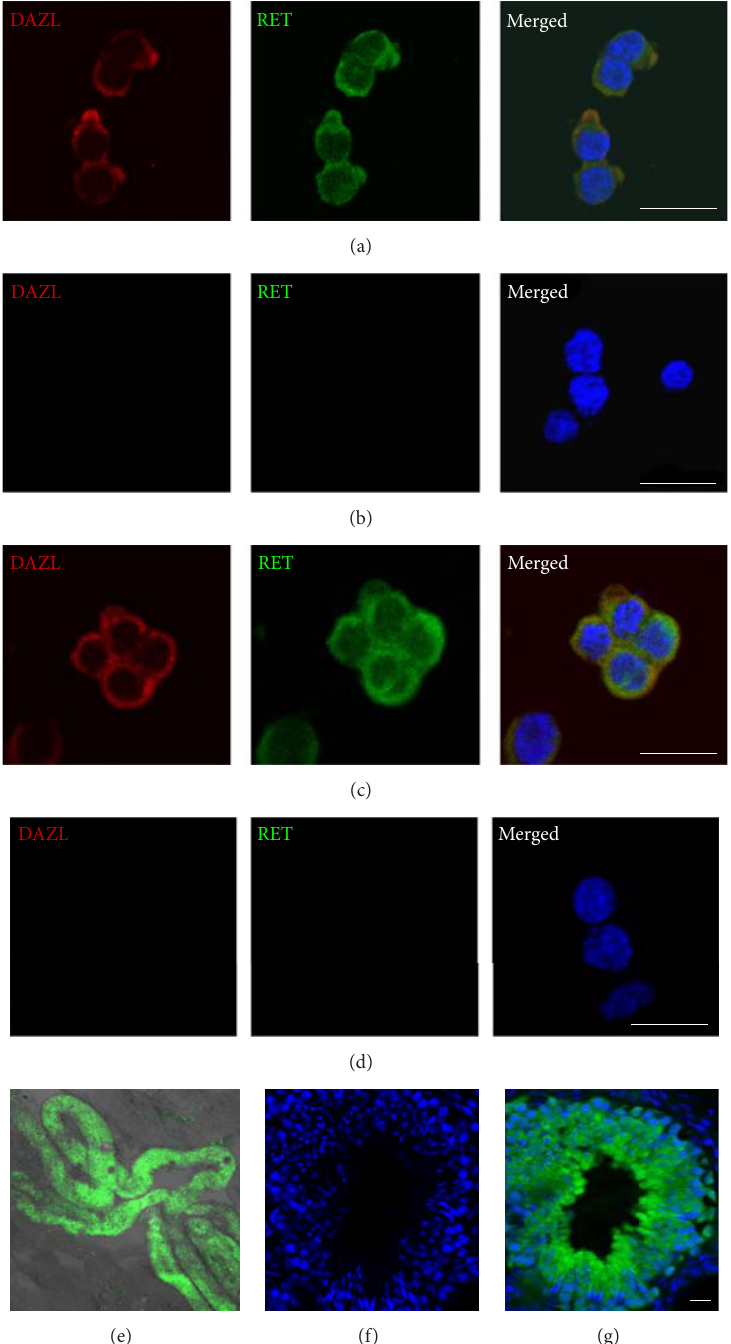
Figure 2: Characterization of cultured spermatogonia by examining SSC marker gene expression and transplantation assays. (a-b) P3 (6 days in vitro ) culture of spermatogonia stained with antibodies against DAZL and RET (a) and nonspecific IgG (b). (c-d) P33 (180 days in vitro ) culture of spermatogonia stained with antibodies against DAZL and RET (c) and nonspecific IgG (d). (e) Fluorescent image of seminiferous tubules of a recipient testis at 6 months after receiving Ub-EGFP-lentivirus infected spermatogonia. Note the extensive recolonization of green cells in the seminiferous tubules. (f-g) Cross-section of a seminiferous tubule recolonized by green germ cells at various differentiating stages. Scale bar: 20 𝜇